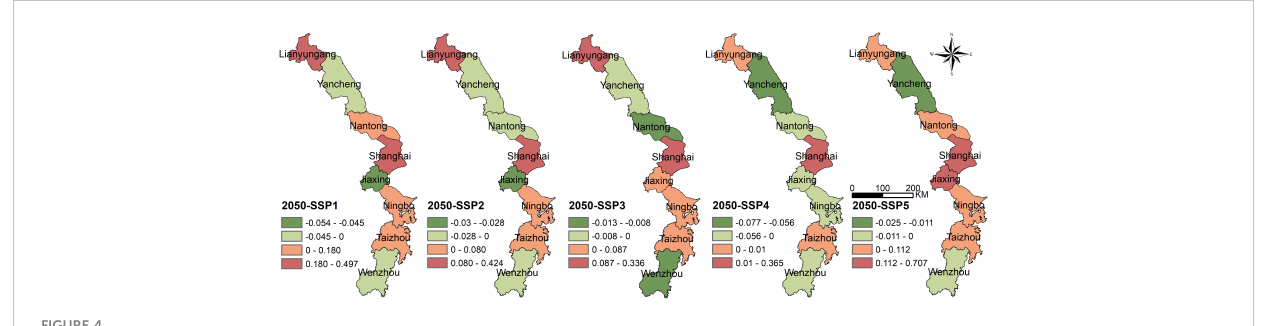
FIGURE 4 Trends of CRECC under different SSPs scenarios in the Yangtze River Delta coastal zone from 2020 to